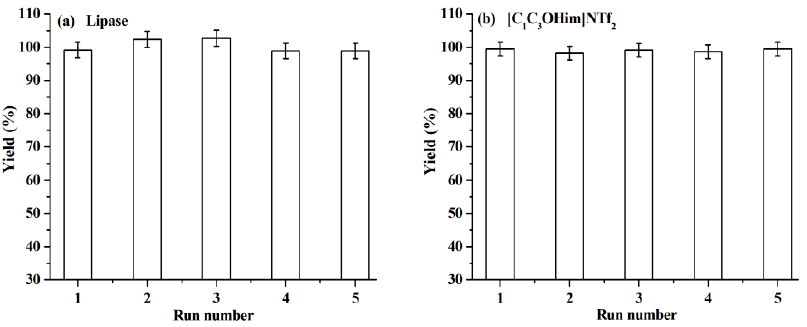
Figure 5. Reusability study of lipase ( a ) and [C 1 C 3 OHim]NTf 2 ( b ) under the optimal reaction conditions.